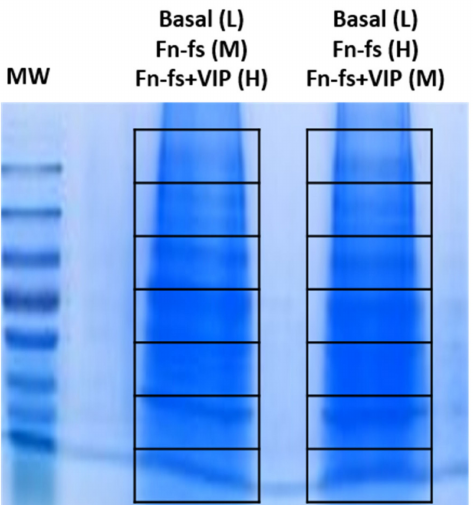
Figure 7. One-dimensional gel electrophoresis separation of SF-AC co-cultures secretome proteins. was sliced into 7 sections and each lane was subjected to nanoLC-MS/MS analysis. MW, molecu- lar weight markers; L, light; M, medium; H, heavy; Fn-fs, fibronectin fragments; VIP, vasoactive intestinal